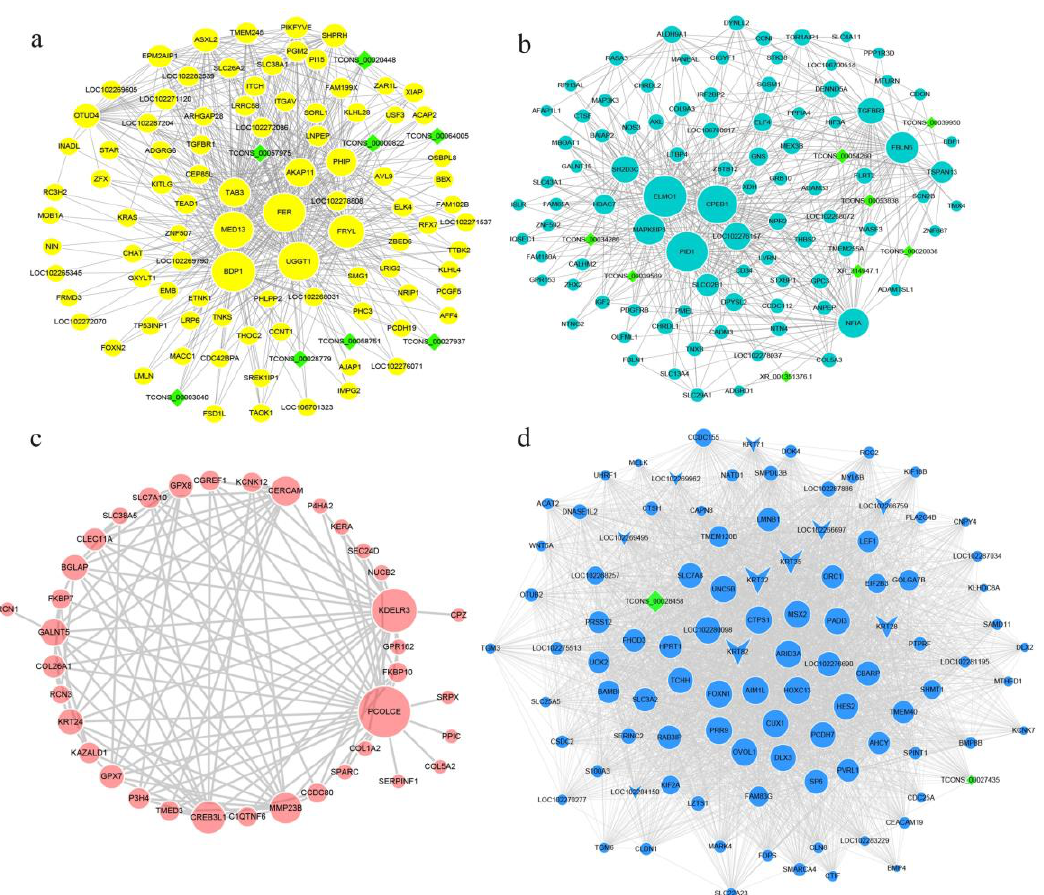
Figure 3. The co-expression network of the genes in top 100 connectivity in the key four modules. The networks are represented with their corresponding module colors, including the yellow, turquoise, red, and blue module networks ( a – d ). Genes in the red module network are less than 100 that were all exhibited. Circle represents mRNAs, diamond represents lncRNAs, the V shape in the blue network represents the keratins. The size of nodes represents the connectivity of genes in the co-expression network—the larger the nodes, the higher the connectivity and the more critical it is in the network and could be used as hub genes.